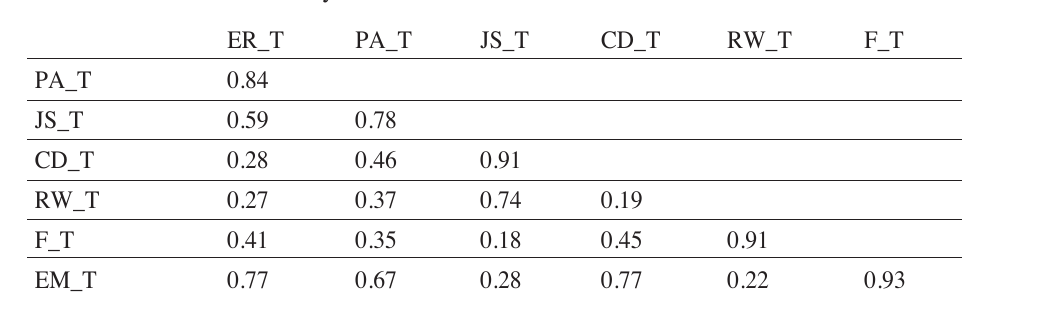
Table 5: Discriminant